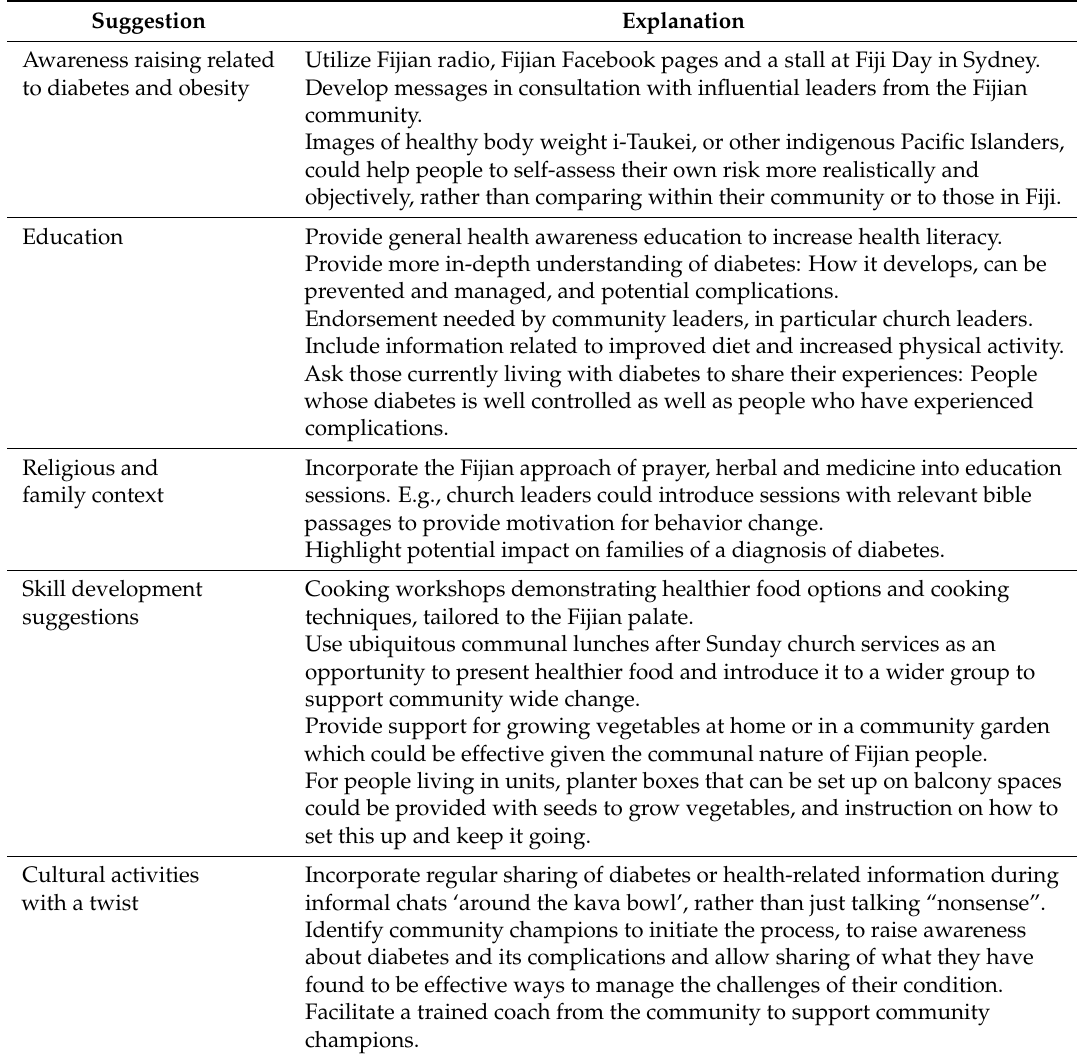
Table 6. Intervention suggestions to prevent, and improve management of,